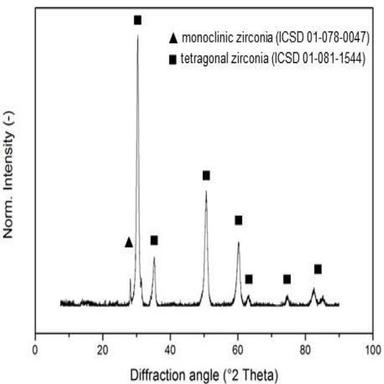
X-ray diffraction pattern of the 10Mg–Zr fibers sintered at 700 °C with a heating rate of 1 K/min.